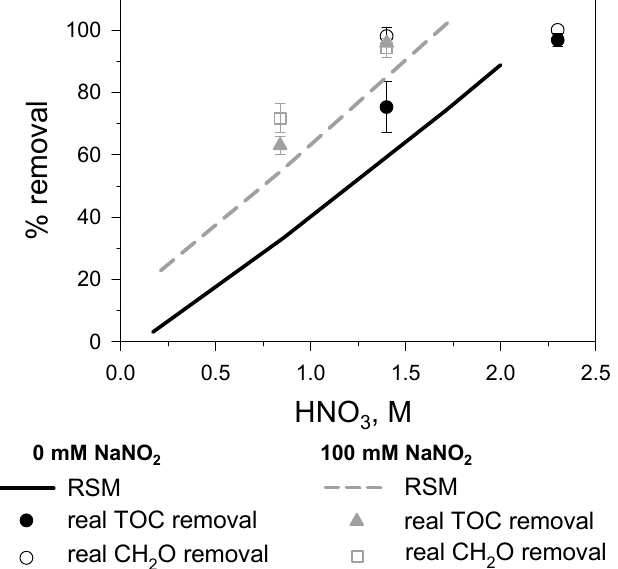
Figure 6. RSM for 85 °C and the corresponding real values for TOC removal and formaldehyde removal.